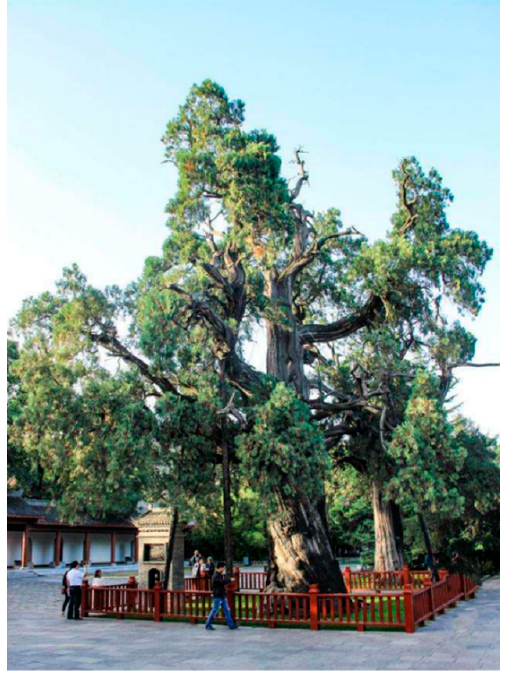
Figure 3. Huangdi “Hand-planting Arborvitaes”, which are more than 5000 years old. The detection of tree roots has always been a difficult issue for NDT of trees. GPR is considered to be a potential solution to this problem. In this project, trunk’s internal defects and root distribution are detected successfully using GPR. However, for complete non-destructiveness, no other NDT techniques are used for cross-validation, and there may be large biases in the results